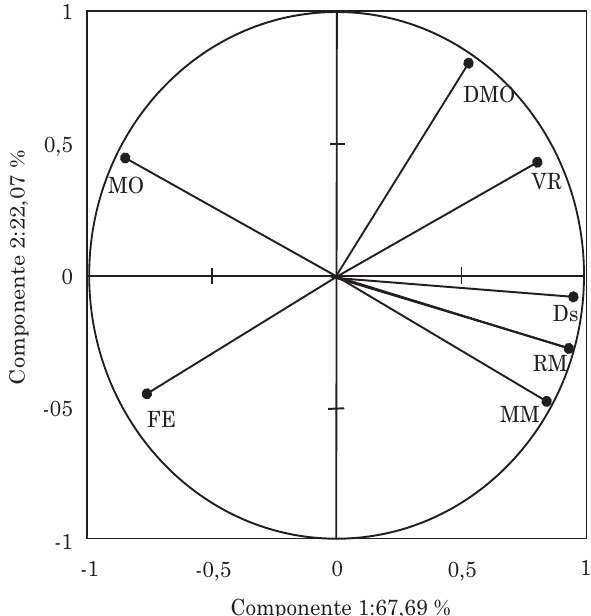
Figura 1. Diagrama de ordenação produzido por análise de componentes principais dos atributos do solo: densidade da matéria orgânica (DMO), volume residual (VR), densidade do solo (Ds), resíduo mínimo (RM), material mineral (MM), fibras esfregadas (FE) e matéria orgânica (MO).